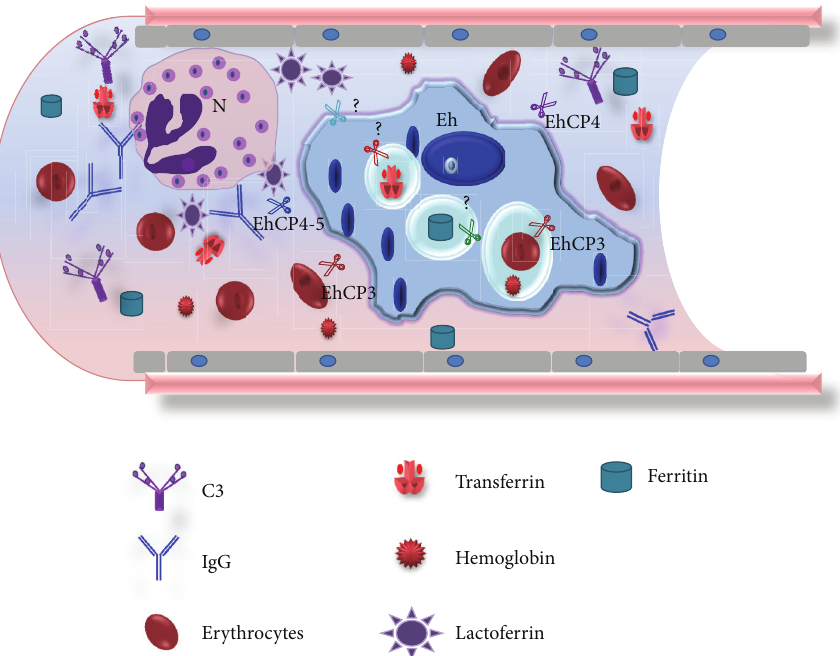
Figure 2: E. histolytica proteases participating during trophozoite transit in blood vessels.